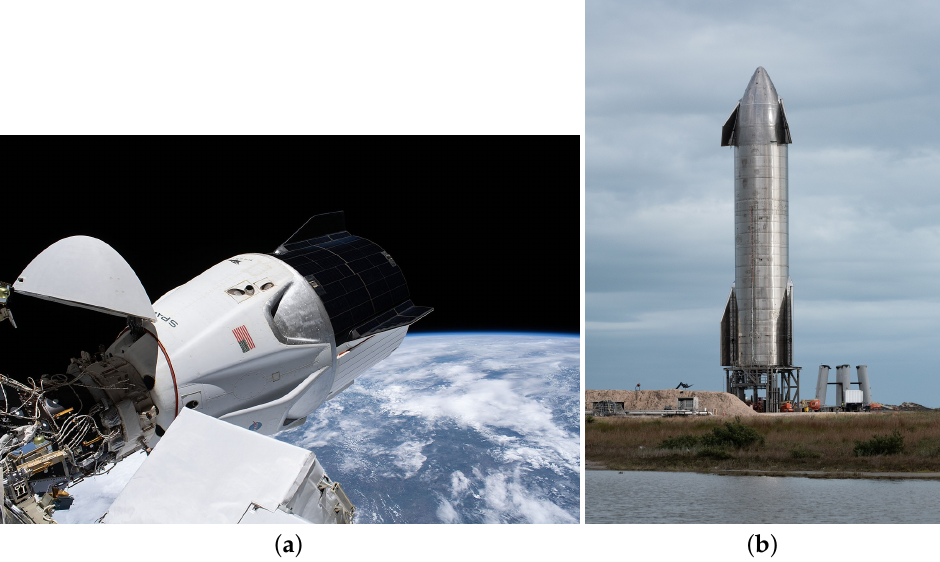
Figure 2. ( a ) The SpaceX Crew Dragon spacecraft docked to the ISS in 2021 [2]; and ( b ) Starship Serial Number (SN) 9 sitting on its launch pad in Starbase